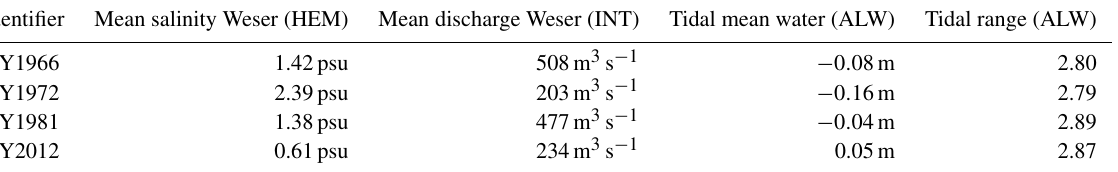
Figure 4. Intratidal and seasonal variation of saltwater intrusion in the Weser estuary. The water level at the Leuchtturm Alte Weser (ALW) station, discharge at the Intschede (INT) station, and salinity along the navigation channel of the Weser estuary are displayed on different time scales. Salinity values were interpolated linearly between measurement stations with available measurements along the navigation channel. The 5psu isohaline is displayed in white. On top, salinity variation in 1 day, 1 September 2012, is depicted (a) . Below, variation in the hydrological year 2012 of the mean salinity per tidal cycle is depicted (b) . We applied a moving median filter to the water level data in (b) to show the seasonal variation (filter size 12h 25min). Table 3. Characteristic conditions in system states 1966, 1972, 1981, and 2012, averaged for 1 hydrological year based on measured values. Mean salinity and mean discharge were measured at Hemelingen (HEM) and Intschede (INT). Both stations are located upstream of the Bremen weir. Tidal mean water and tidal range in the North Sea were measured at Leuchtturm Alte Weser (ALW).